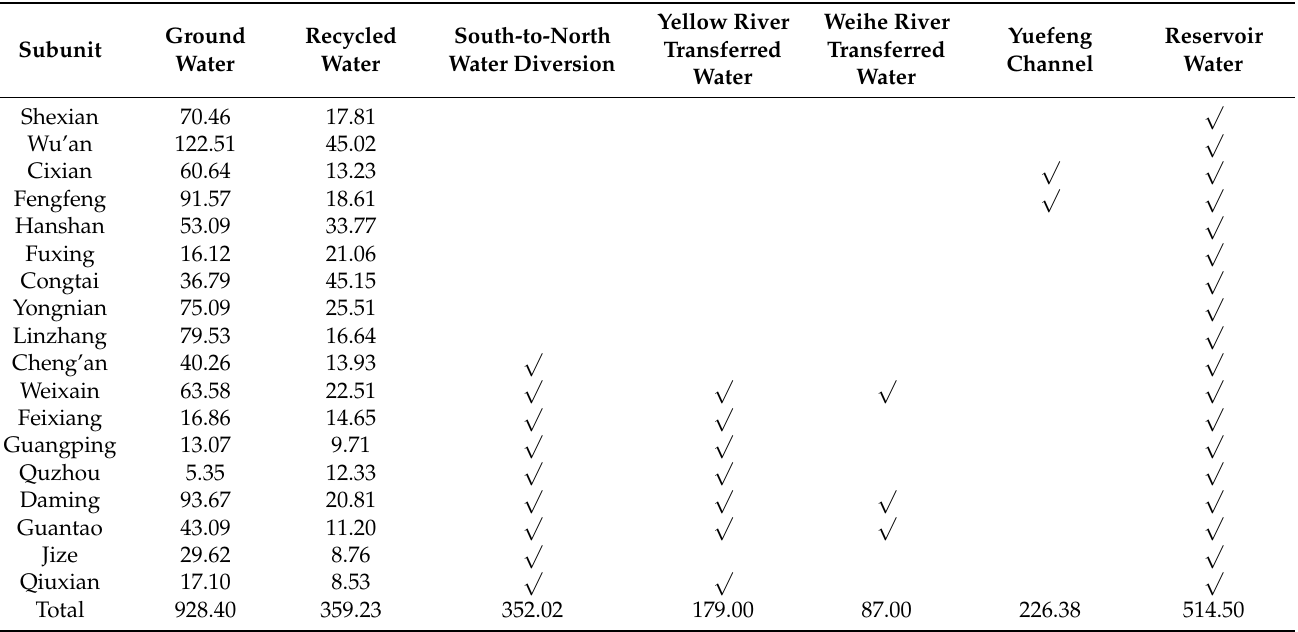
Table 2. Prediction results of the available water supply of different water sources in Handan in 2025 (P = 50%; 10 6 m 3